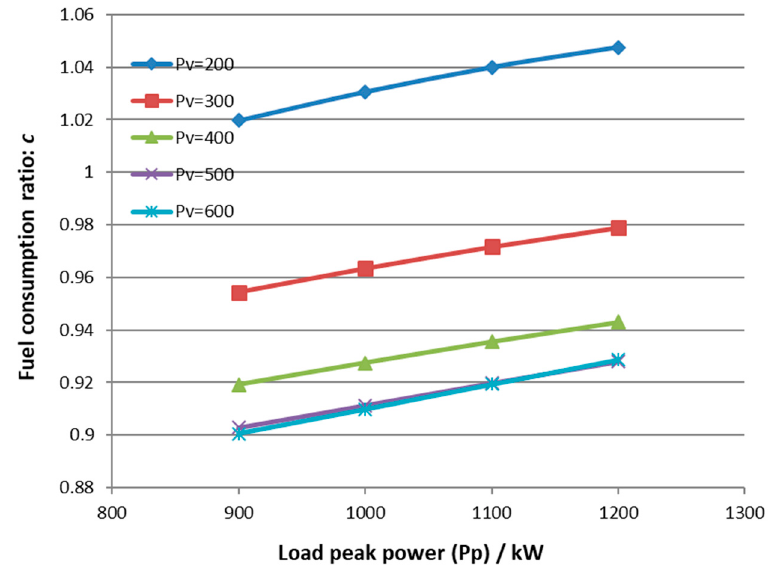
Figure 9. Fuel consumption ratio comparison ( t = 5 , η = 0.75 , r = r t ).